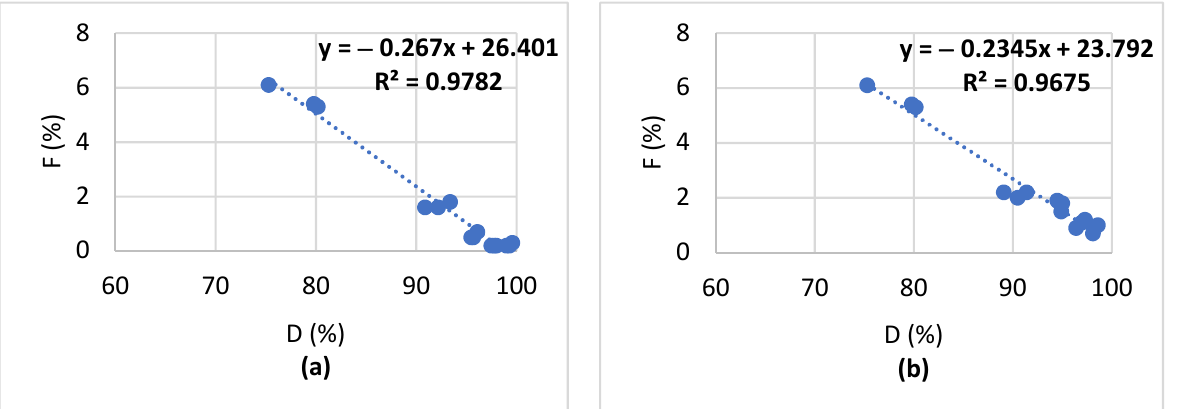
Figure 3. Correlations between durability and fines of agripellets: ( a ) blends of olive pruning residues; ( b ) blends of vineyard pruning residues.